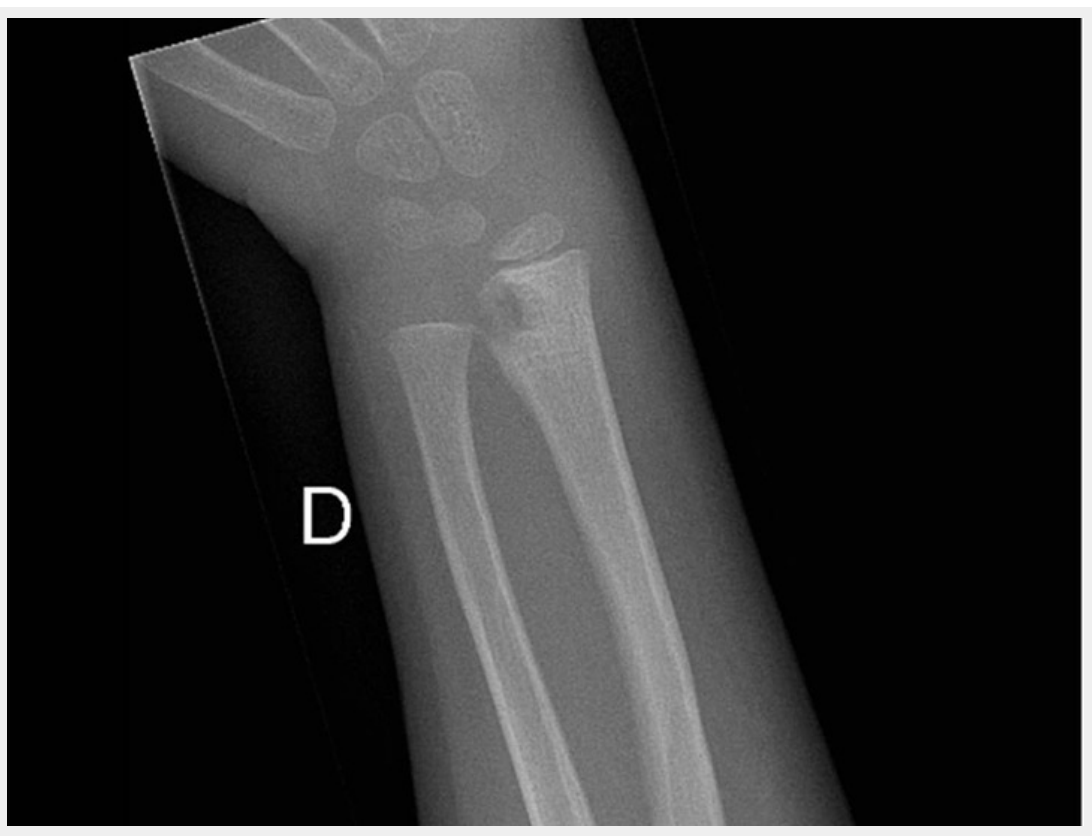
Figure 4 Sub-acute transphyseal osteomyelitis of the distal radius due to K. kingae in a 5-year-old boy who suffered from a chickenpox (varicella) infection three weeks before bone infection. This viral infection was considered as a predisposing factor for the development of osteomyelitis due to K. kingae resulting from a modulation of the immune system